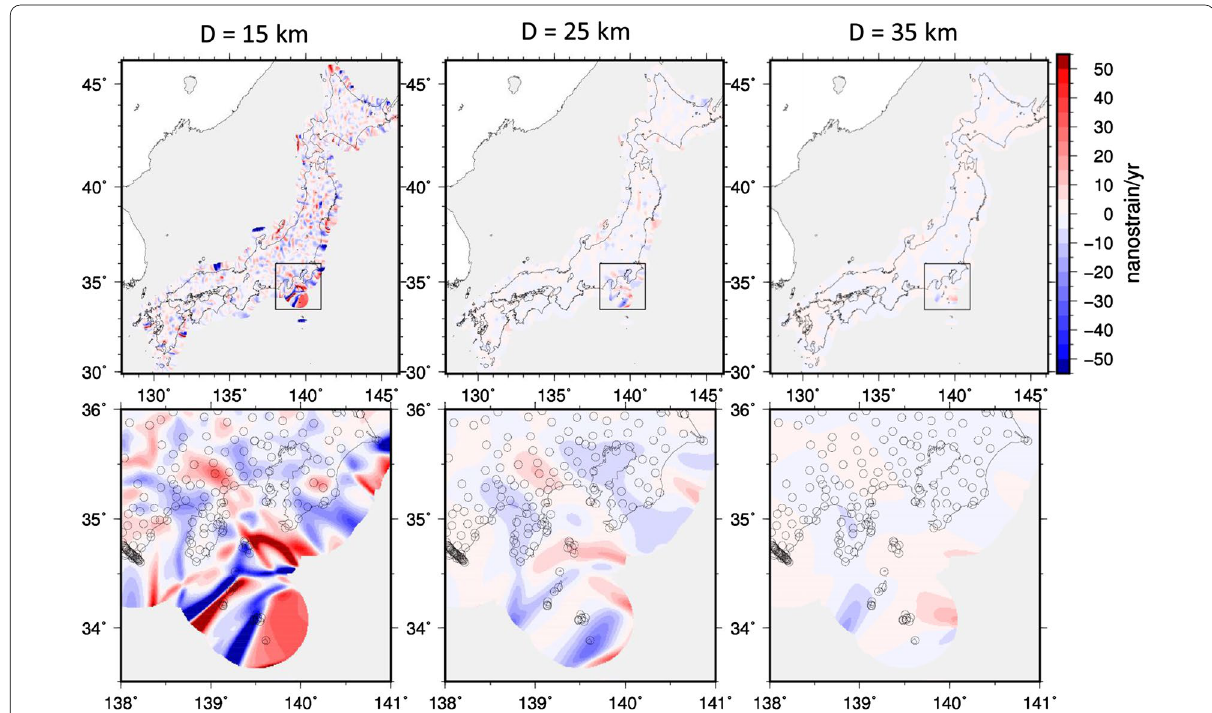
Fig. 12 Discrepancy in strain-rate fields estimated by Shen’s method with different values of D . The discrepancy between the dilatation rate directly obtained by Shen’s method and that calculated from the velocity field through differentiation is shown. Bottom panels show enlarged views around the Izu Islands; the location is indicated by boxes in the top panels. Open circles represent the GNSS stations. Positive dilatation represents expansion